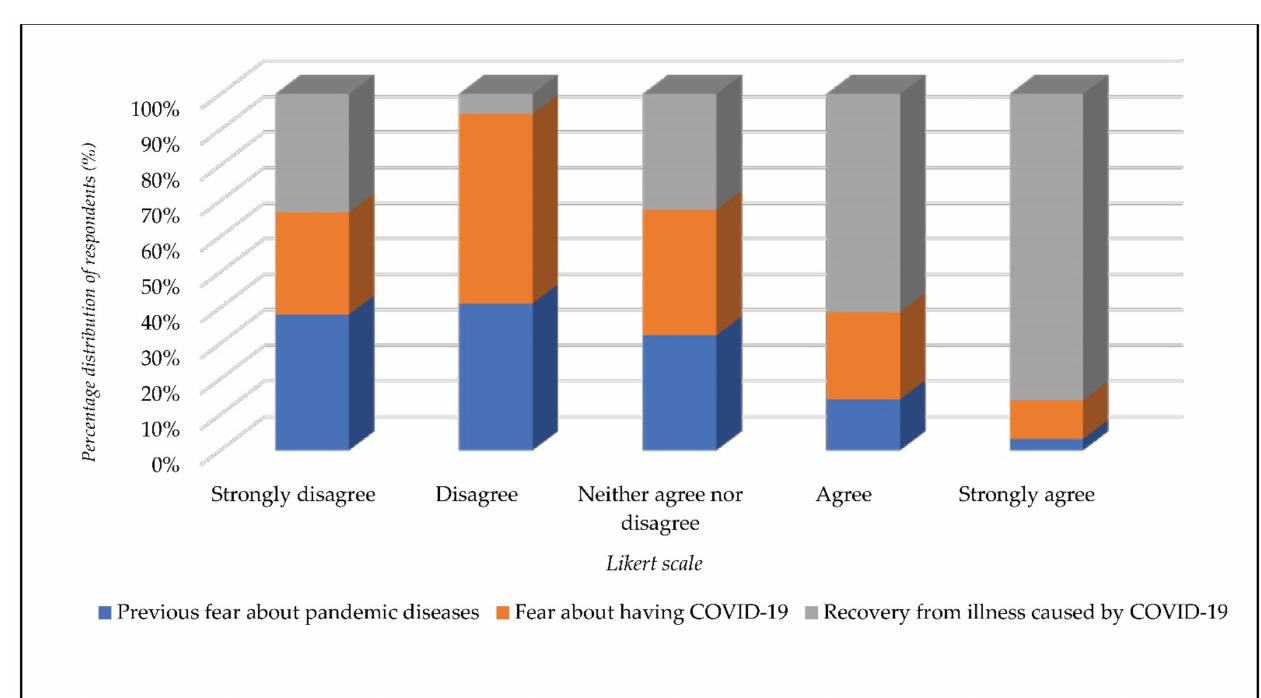
Figure 4. Levels of disaster fear caused by